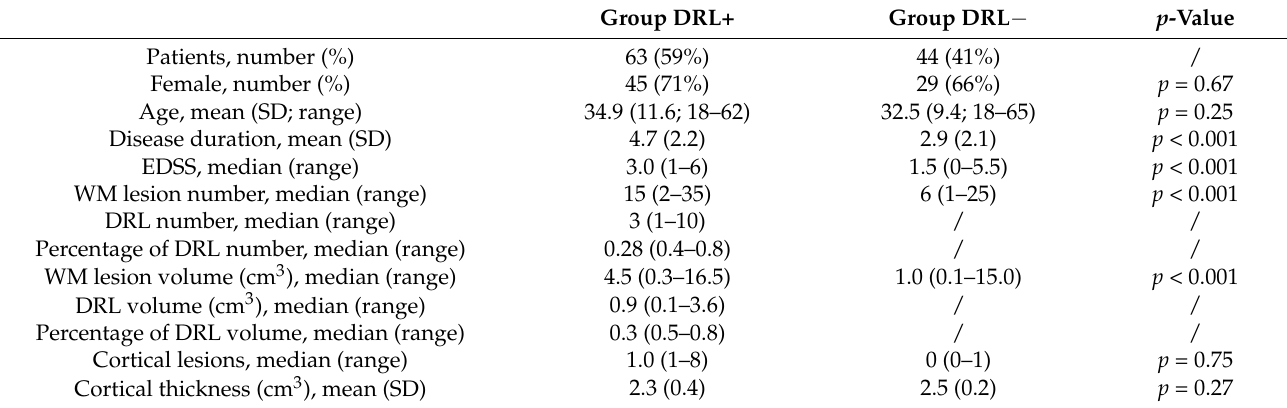
Table 2. Demographical, clinical and MRI characteristics of MS patients with and without DRL at 1.5